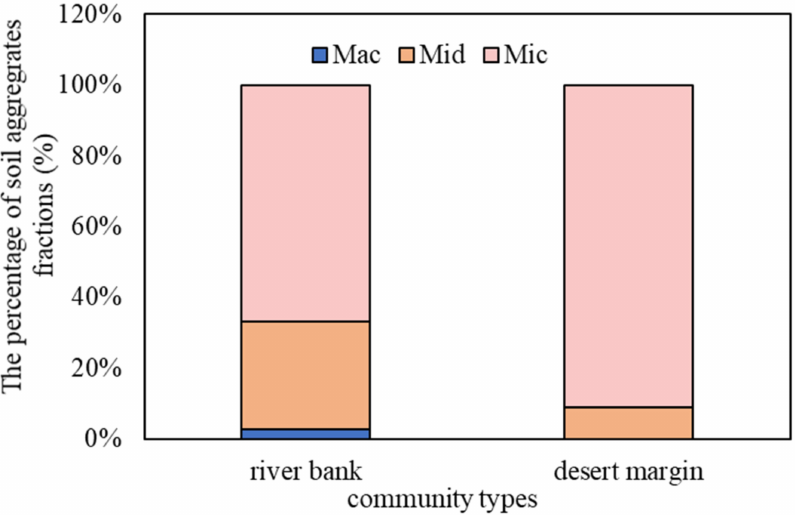
Figure 2. The difference in the soil water-stable aggregate proportion of different communities. Note: Mac, Mid, and Mic represent soil macro-aggregates, intermediate aggregates, and micro- aggregates,